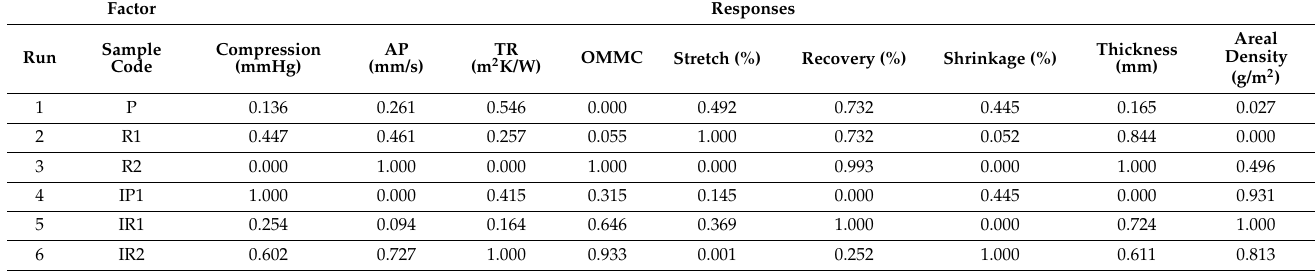
Table 9. Normalized S/N ratio.